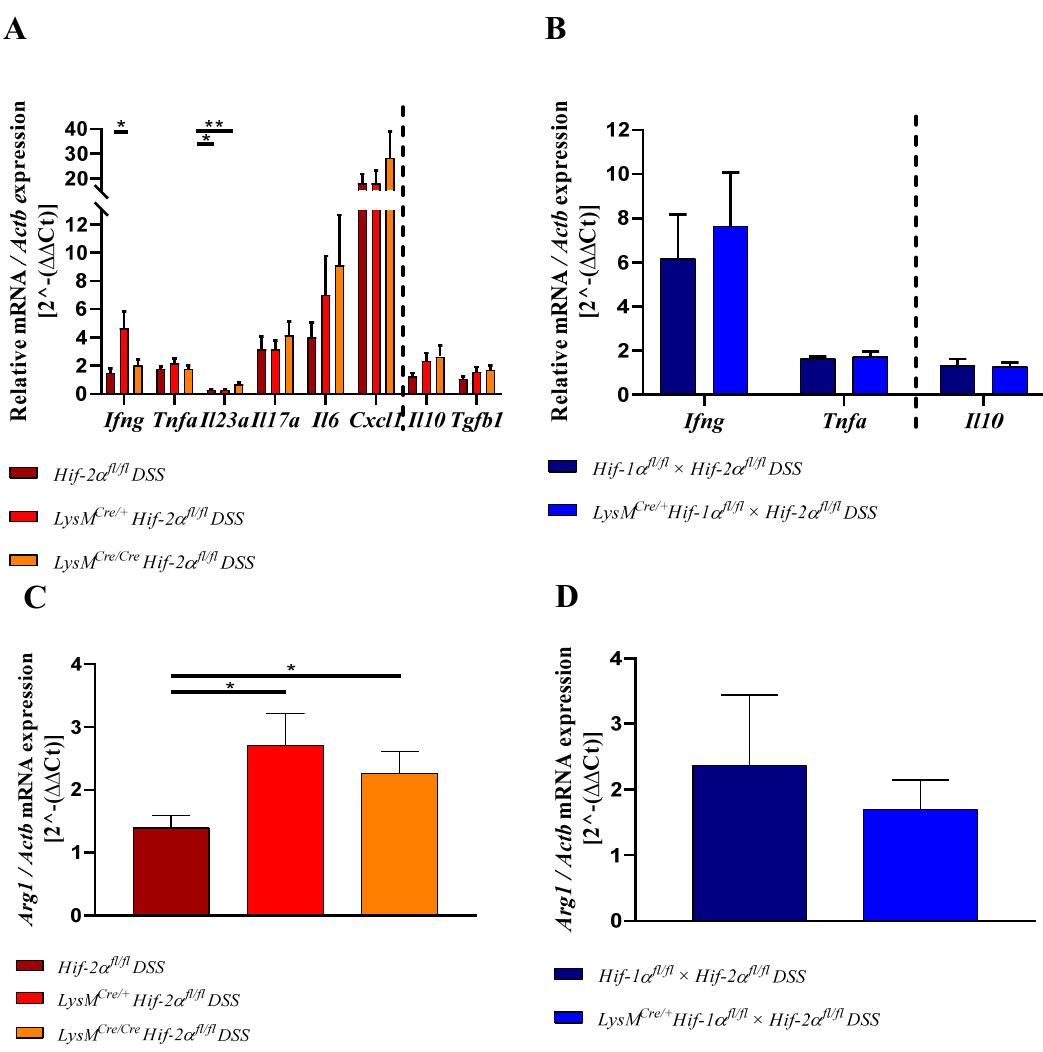
Figure 10. Myeloid knockout of HIF-2 α induces both the pro- and the anti-inflammatory cytokine response during inflammation. Figure 10 ( A , B ) shows the expression of pro- (left of the dotted line) and antiinflammatory (right of the dotted line) cytokines. Cytokines were quantified by qPCR in the colonic tissue of DSS-treated animals. Figure 10 ( C , D ) shows the expression of Arg1 quantified by qPCR. Statistical analysis was performed with an unpaired t -test (mean values ± SEM; A: n = 6 ( LysM Cre / Cre Hif-2 α fl / fl ) / 15 ( Hif-2 α fl / fl ; LysM Cre / + Hif-2 α fl / fl ); B: n = 14). All data were normalized to the untreated wildtype control. Gene expression of untreated animals did not differ markedly from the respective wildtype control and is depicted in suppl. Figure S6. *: p < 0.05; **: p < 0.01.